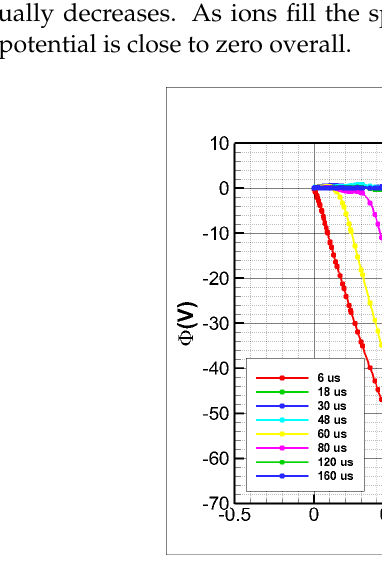
Figure 7. Variation curves of the potential along the z-direction at different times on the axis of symmetry.